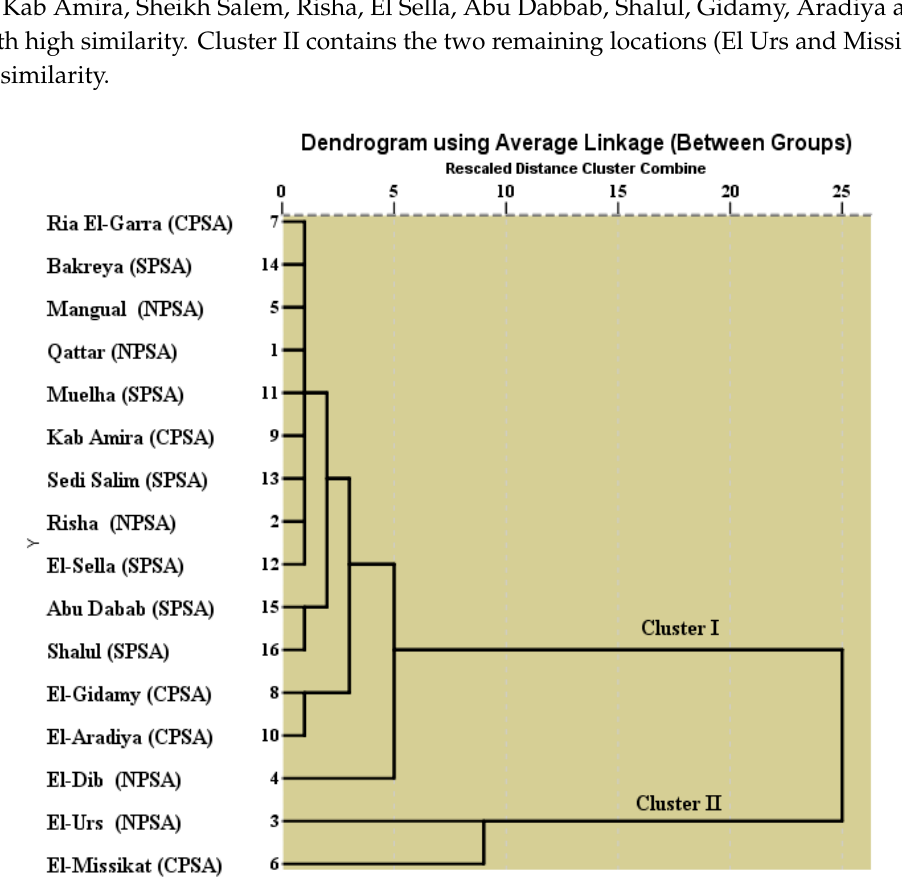
Figure 6. Average values of H ex , H in , I α , I γ and Ra eq in the three parts of the study area (compared to the worldwide averages).